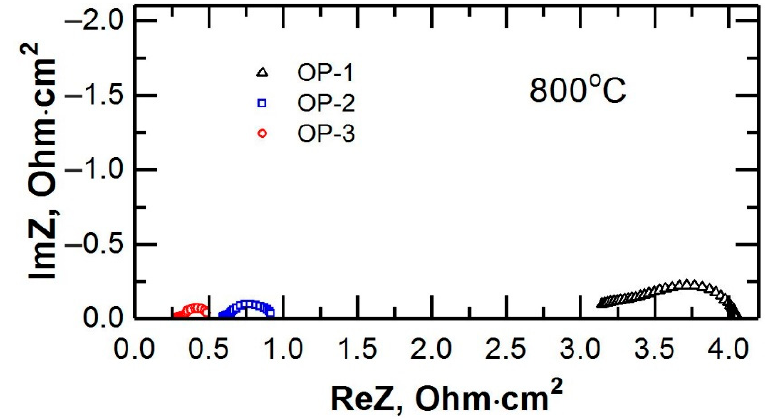
Figure 8. Impedance spectra of the planar oxygen pumps at 800 ° С .